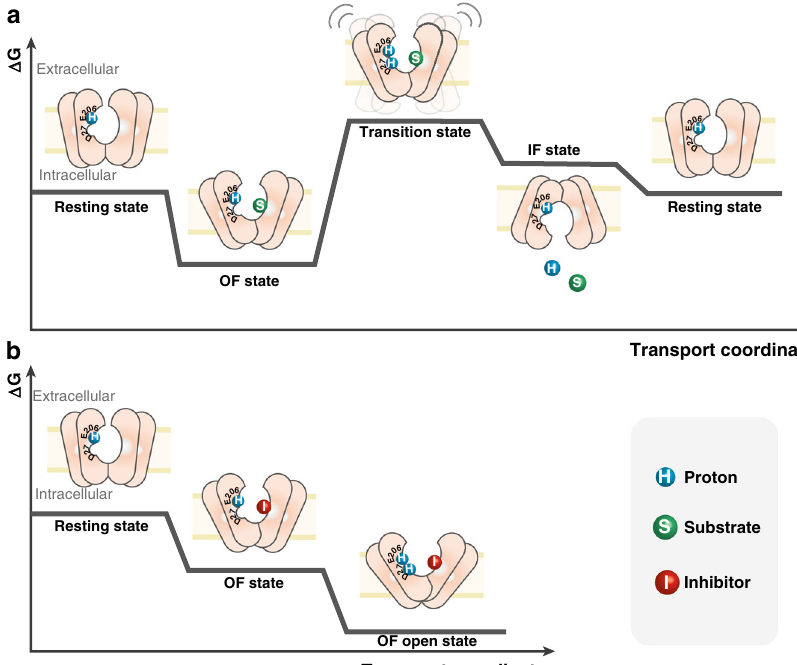
Fig. 7 Ligand-dependent energy landscape of XylE. a Proposed model of the XylE energy landscape in the presence of the substrate xylose. In the resting state, XylE is protonated at E206. Substrate binding stabilizes the OF state. Subsequent protonation of D27 leads to a dynamic “ transition state ” that allows the conformational transition towards the IF state. After substrate and proton release, the transporter switches back to the resting state. b Proposed model of energy landscape of XylE in the presence of inhibitor glucose. Inhibitor binding stabilizes the OF state. Subsequent protonation of D27 further stabilizes the OF state, effectively locking the transporter and preventing the conformational